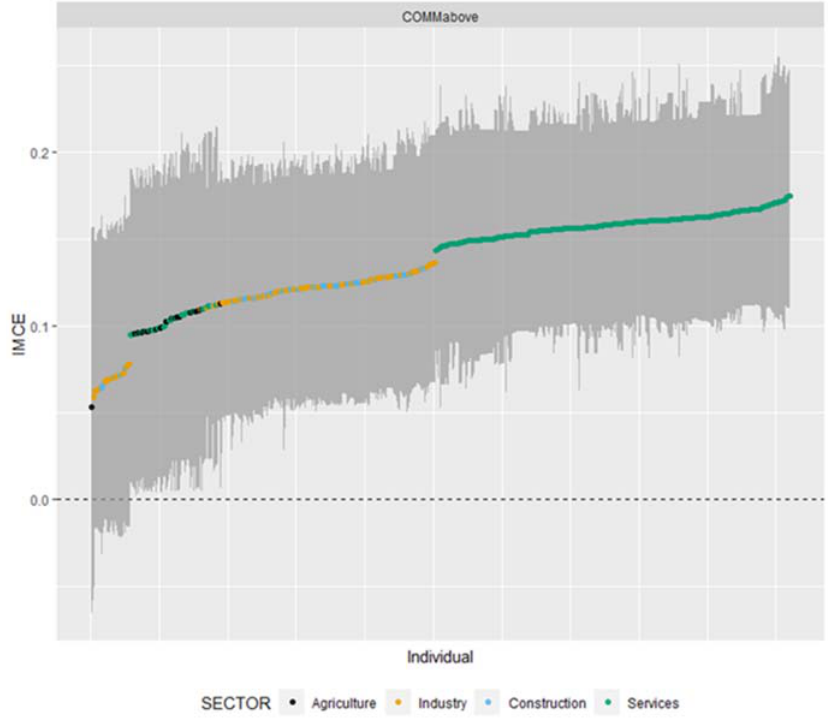
Figure 6. Heterogeneity in IMCE’s by activity sector.